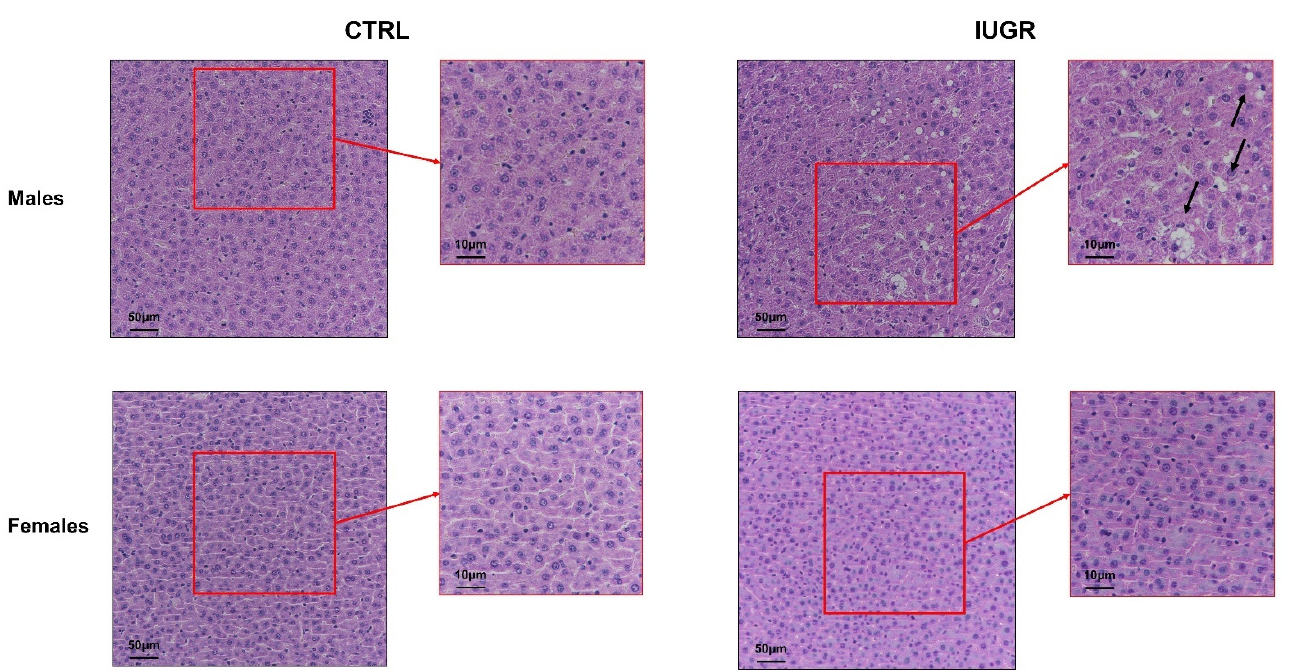
Figure 3 . Liver structure in CTRL and IUGR males and females at 6 months of age. Liver structure was evaluated using H/E staining in males and females. The macro-vesicular steatosis is indicated by black arrows. n = 5 animals/group/sex. Magnification (20 and 40×). Scale bar = 10 and 50 µm.